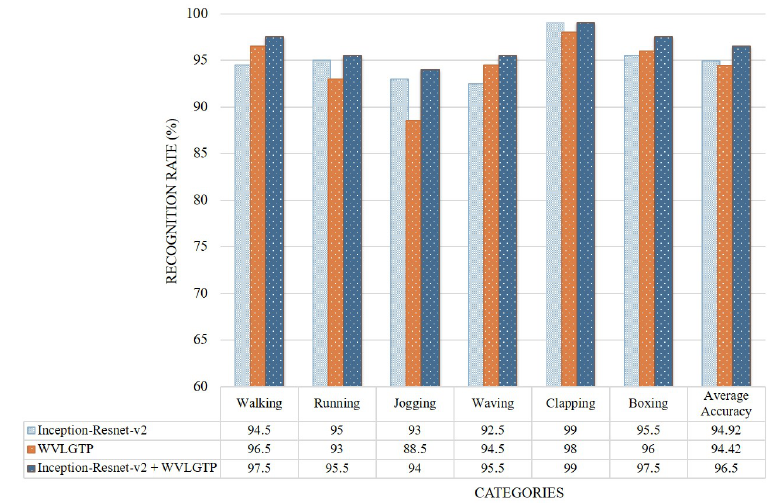
Figure 8. Accuracy comparison of each class by Inception-Resnet-v2, WVLGTP, and Inception-Resnet-v2 plus WVLGTP on the KTH dataset.